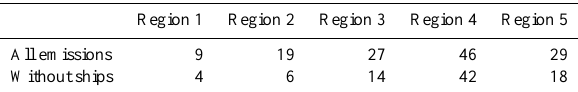
Table 10. Annual number of exceedances of the ozone threshold of 120µgm − 3 . For the regions represented, see Fig.